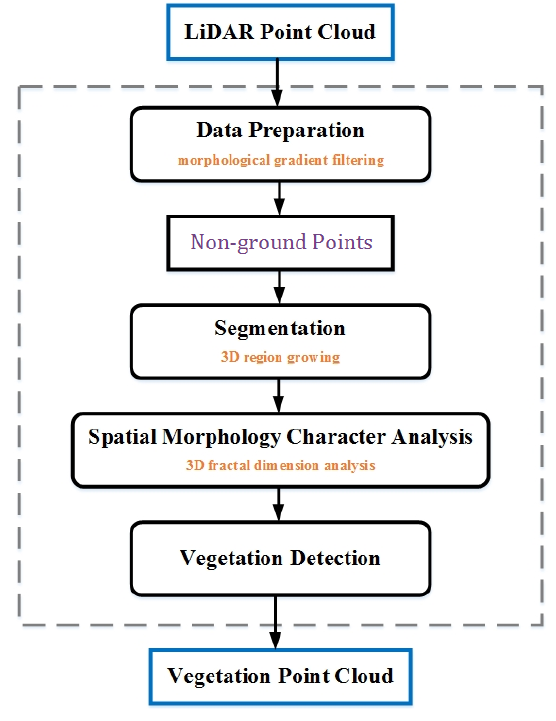
Figure 3. Workflow of vegetation information extraction from LiDAR